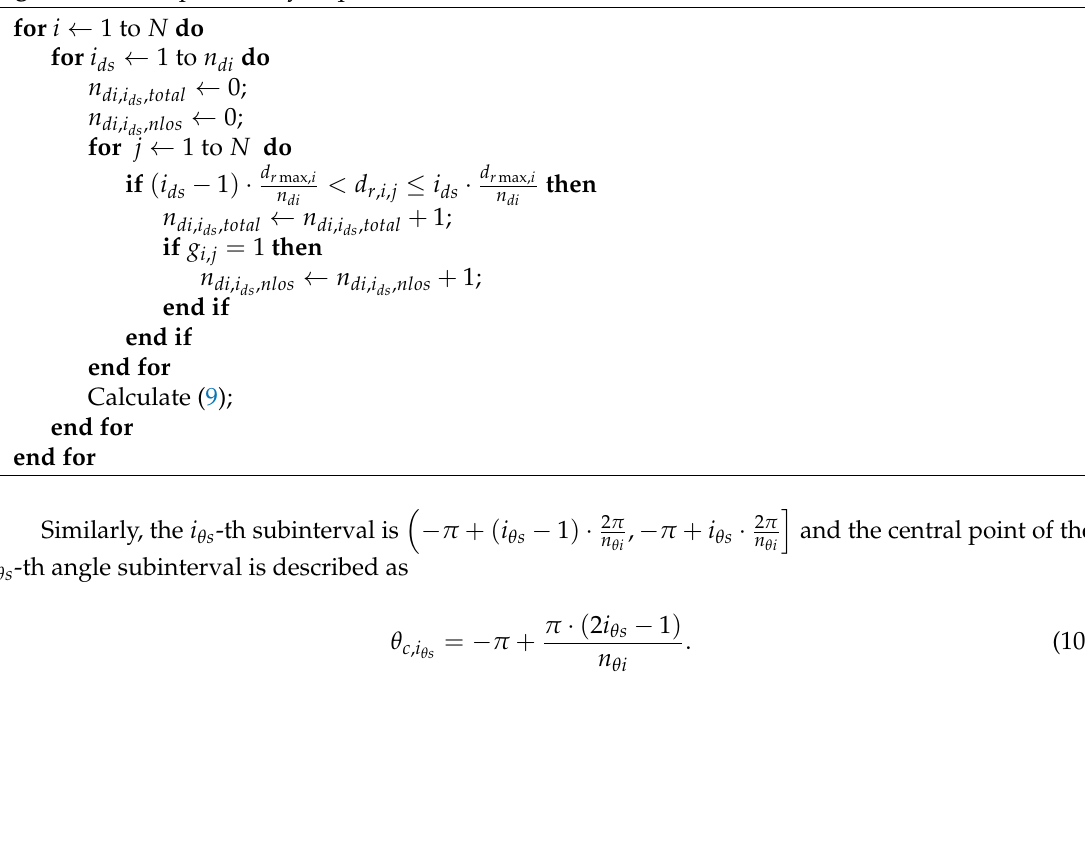
Algorithm 1 The probability acquisition method related to